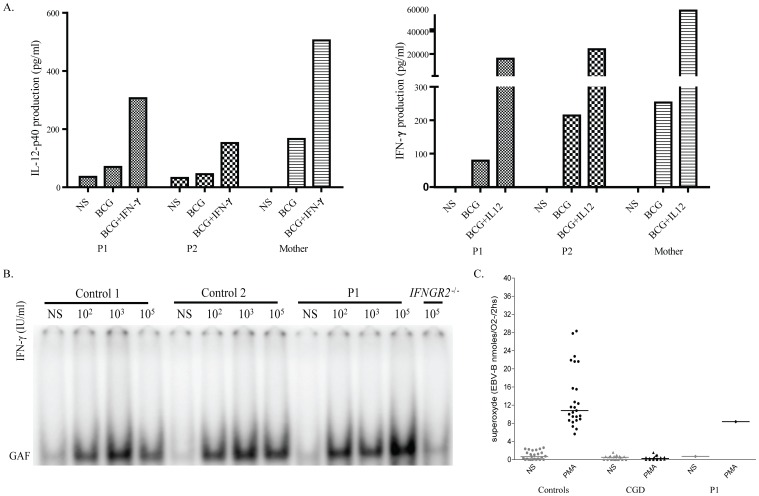
Functional study of the IFN-γ/IL-12 axis and oxidative burst in P1.A). Whole-blood IL-12/IFN-γ pathway screening. P1 and P2 had normal responses to IFN-γ and IL-12. B). EMSA detecting GAF DNA-binding activity after IFN-γ stimulation in the EBV-B cells from two healthy controls, P1 and individuals with complete recessive IFN-γR2 deficiency, used as a negative control. Cells were stimulated for 15 minutes with the indicated dose of IFN-γ. C). Oxidative burst. The production of superoxide in the EBV-B cells from healthy controls, P1 and patients with chronic granulomatous disease, used as negative controls, was determined following stimulation with PMA. These experiments were carried out at least twice.